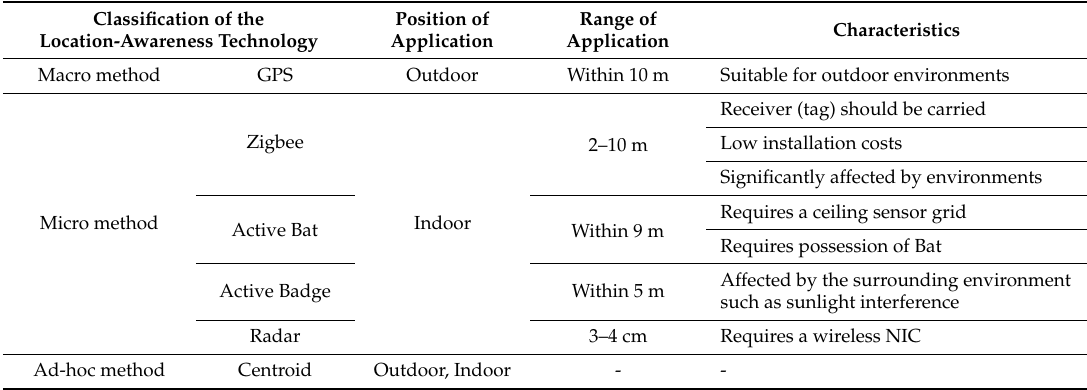
Table 2. Classification and characteristics of location-awareness